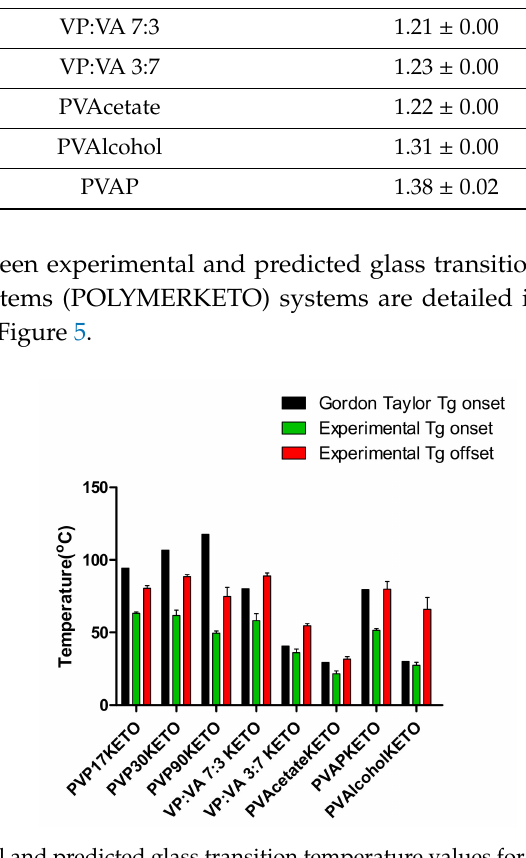
Figure 5. Experimental and predicted glass transition temperature values for POLYMERKETO systems with 20% w / w